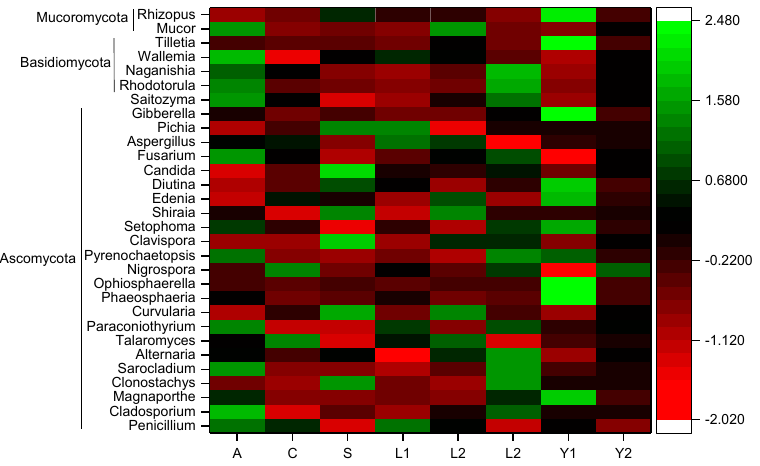
Figure 3. Heat map of the fungal community variation on rice grain. The highest relative abun- dance of 30 fungal genera were selected to generate the heat map. The color-coding was based on the average relative abundance at the genus level of each sample. Table 3. Multivariate analysis of variance of the orientation, vertical position and storage time effect on fungi. Sums of Mean Squares F.Model R 2 p -Value Squares